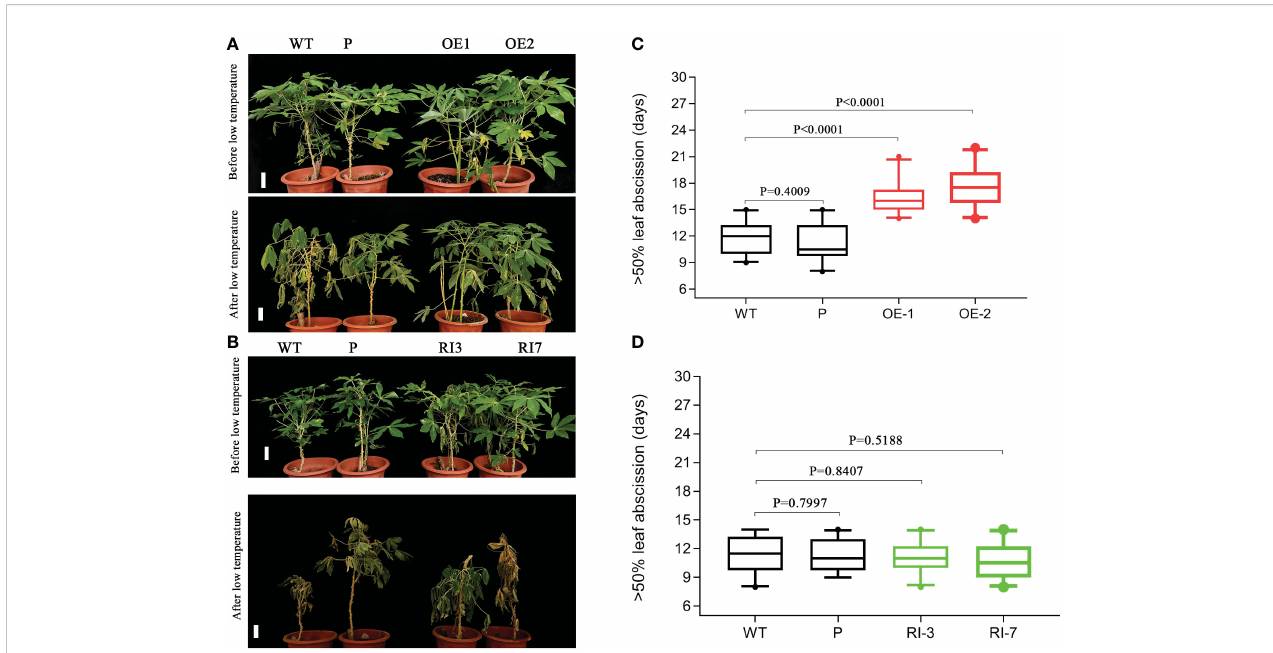
FIGURE 4 MebHLH18 transgenic cassava plants showed that MebHLH18 expression alleviated leaf abscission exposed to low temperatures. (A) MebHLH18 overexpression lines (OE), wild-type plants (WT) and overexpression empty vector lines (P) recovered 10 days after a 4°C low-temperature treatment exposure. (B) MebHLH18 RNAi lines (RI), wild-type plants (WT) and overexpression empty vector lines (P) recovered 10 days after a 4°C low-temperature treatment exposure. (C) The leaf abscission in overexpressing MebHLH18 lines, WT, and overexpressing empty vector showing the time (day) until >50% of leaves had abscised after a 4°C low-temperature treatment exposure. (D) The leaf abscission in knockdown, WT, and overexpressing empty vector showing the time (day) until >50% of leaves had abscised after a 4°C low-temperature treatment exposure. All samples were collected from 120-day-old cassava plants for analysis. The data in the graph is expressed as mean ± standard error based on four technical replicates (n=20). Bar=50 mm. Mann Whitney test based on ranks in (C, D)